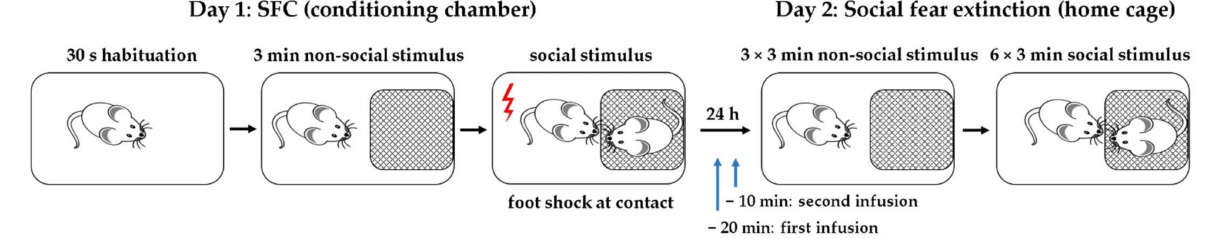
Figure 1. Schematic representation of the social fear conditioning (SFC) paradigm. On day 1, during SFC, the mice were placed in the conditioning chamber and, after a 30 s habituation period, an empty wire mesh cage was placed as a non-social stimulus near one of the short walls. After 3 min, the non-social stimulus was replaced by an identical cage containing an unfamiliar mouse, i.e., social stimulus. Mice were given a mild electric foot shock each time they investigated the social stimulus. On day 2, during social fear extinction, the mice were exposed in their home cages to three non-social stimuli, followed by exposure to six unfamiliar social stimuli. Twenty min before social fear extinction, the mice received the first infusion (vehicle, BIBO3304 trifluoroacetate or BIIE0246). Ten min later, the mice were infused again with either vehicle or